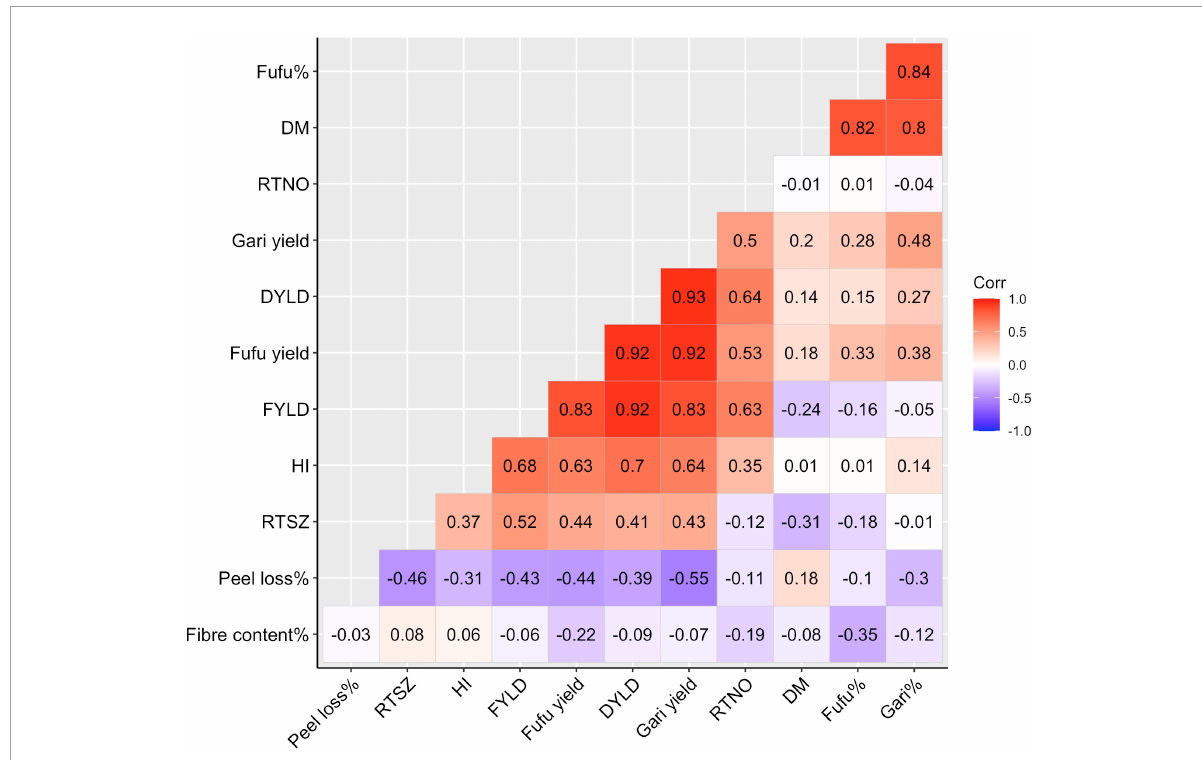
FIGURE2 Correlation plot for processed products traits, and yield and root morphological traits using deregressed BLUPS form 8 environments. DM, Drymatter; RTNO, Root number; DYLD, Dry root yield; FYLD, Fresh root yield; HI, Harvest index; RTSZ, Root